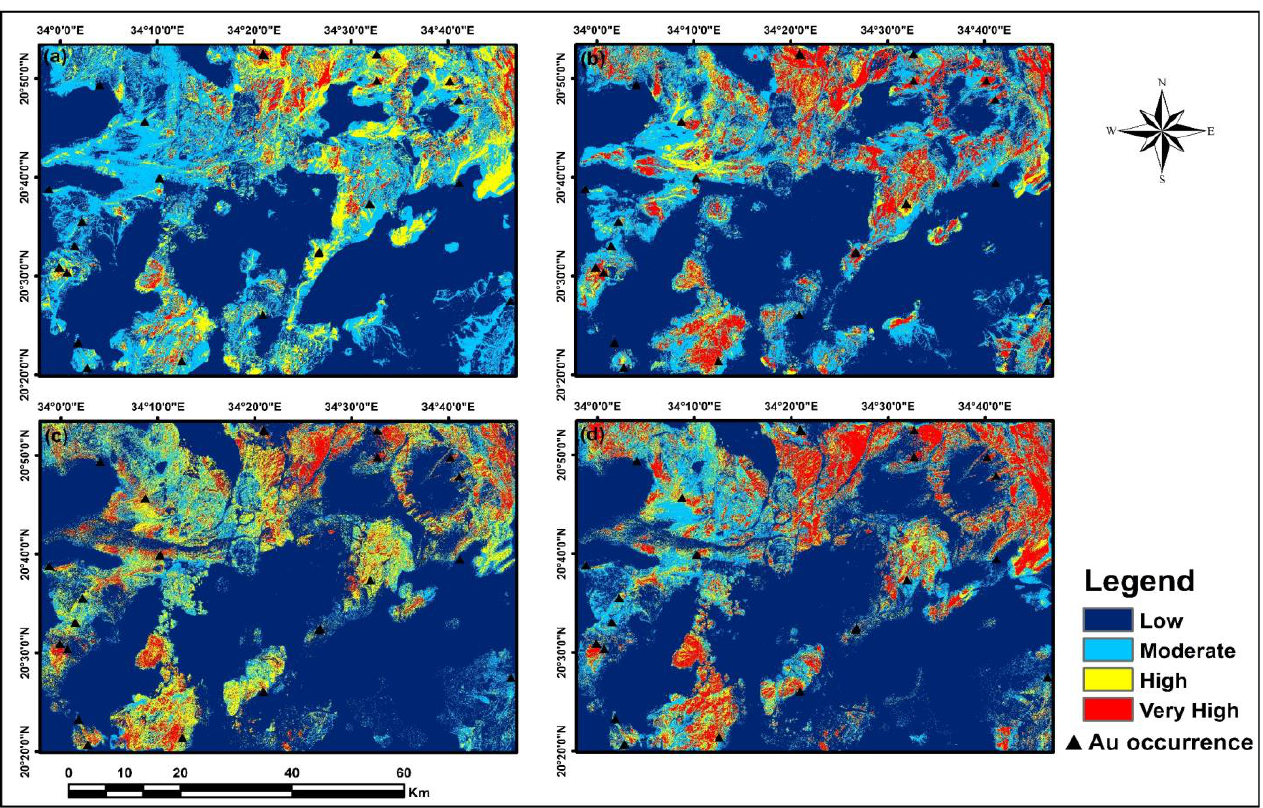
Figure 15. Reclassified gold prospectivity maps based on threshold values derived from success-rate curves: ( a ) Landsat-8; ( b ) Sentinel-2; ( c ) ASTER; ( d ) data-integration.